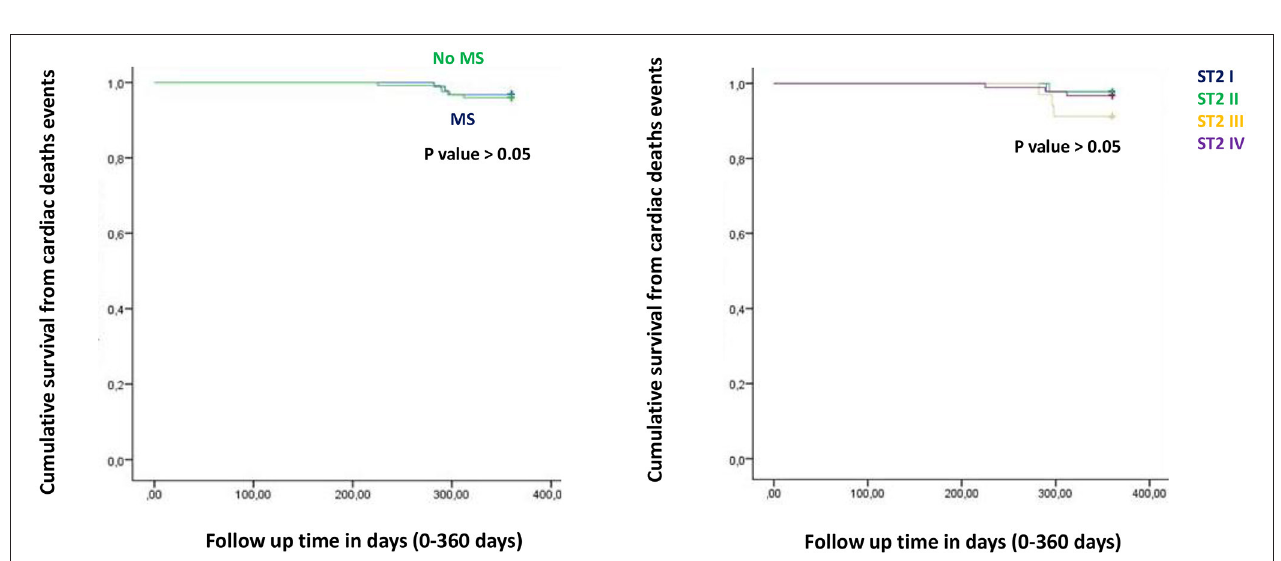
FIGURE 2 | The curve representation of cardiac deaths events as “cumulative survival from cardiac deaths events” (on y axis) during 360 days follow up (on x axis) comparing MS vs. no MS patients (left part), and different quartiles (right